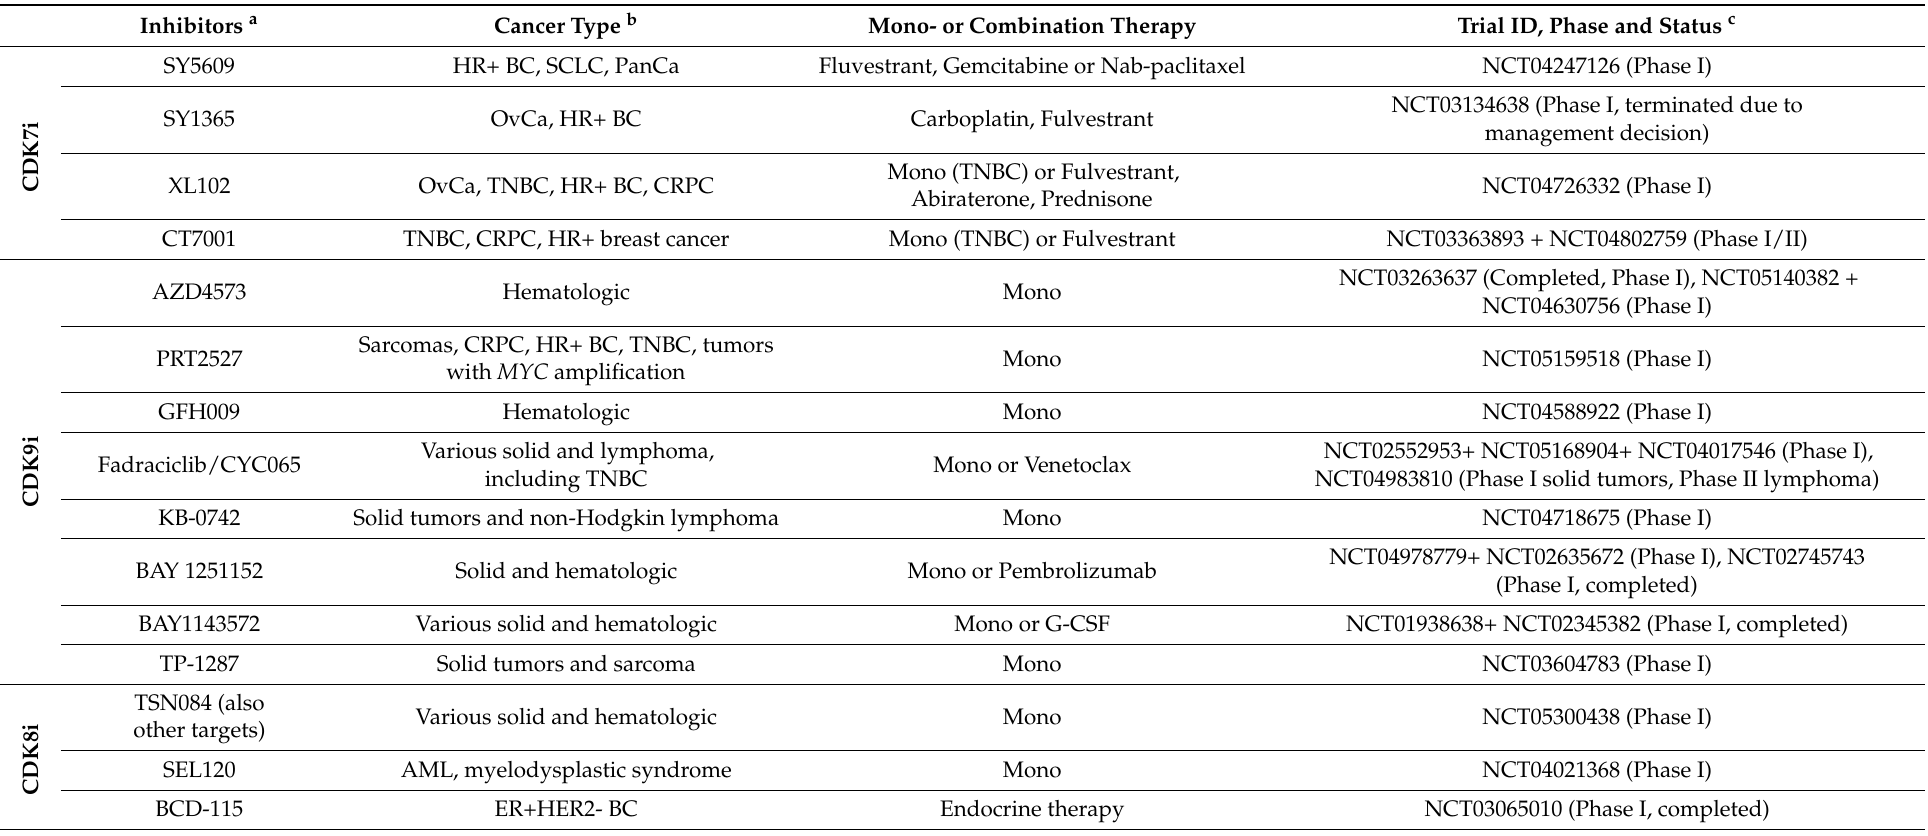
Table 2. Overview of clinically tested